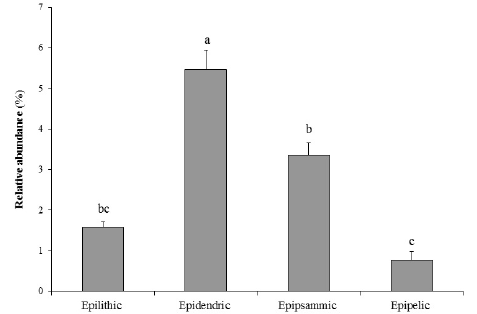
Figure 3. Relative abundance (mean ± SD) of P. laevis on different substrates ( χ 2 =11.16; P < 0.05).